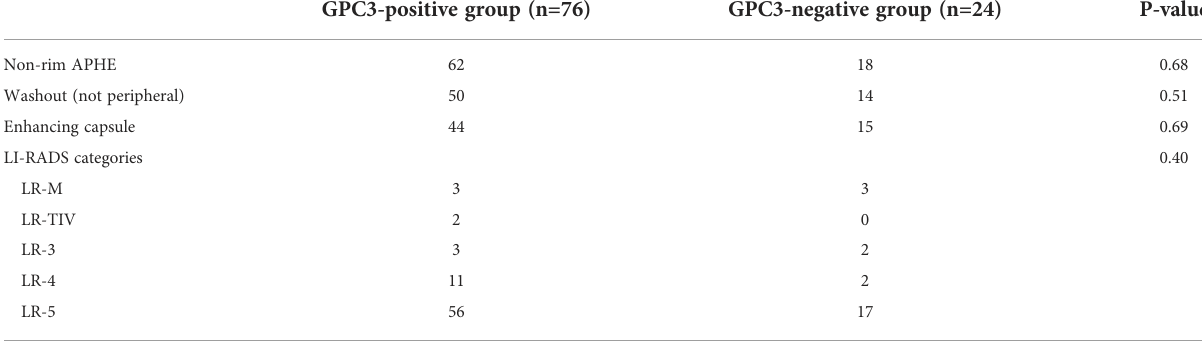
TABLE 2 Standard MRI features and LI-RADS categories of HCC lesions in the two groups.